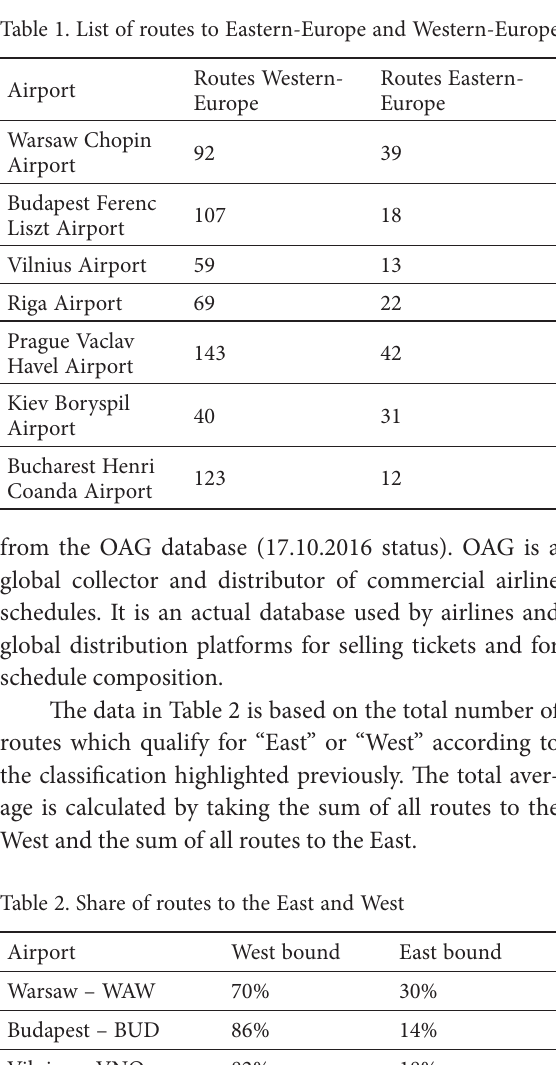
Routes Western- Europe